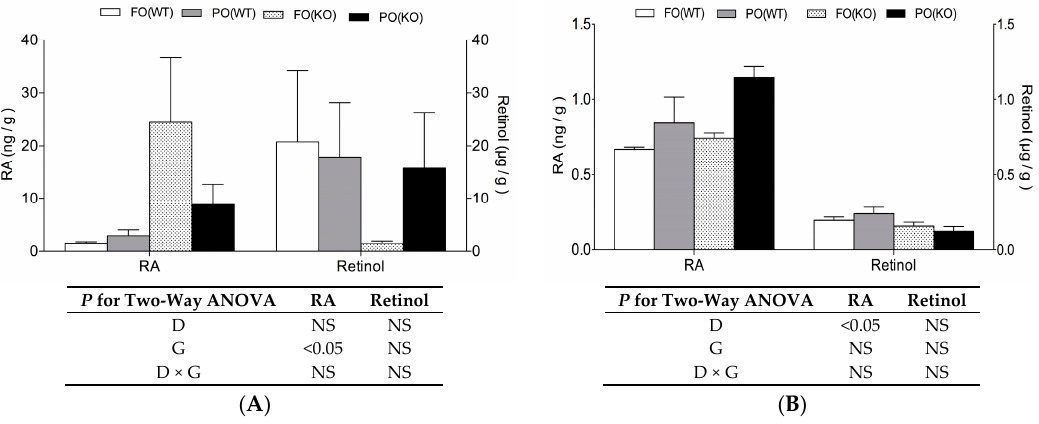
Figure 1. Retinol and retinoic acid (RA) concentrations in maternal liver ( A ) and fetus ( B ) of WT and KO mice receiving FO or PO diets during pregnancy. Samples were collected at pregnancy day18. Data are mean ± SEM, n = 5. Results of two-way ANOVA are shown in table (D, diet; G, genotype; D × G, interaction; NS, not significant).